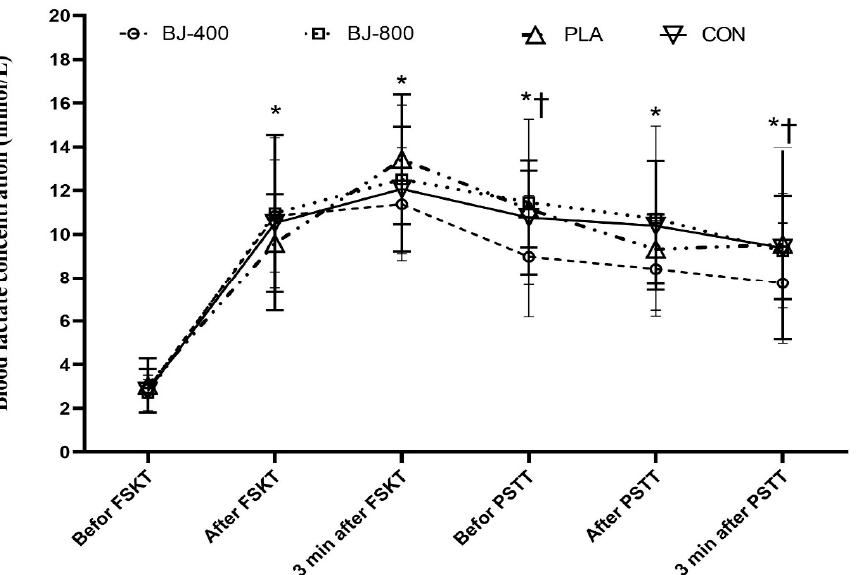
Figure 6. Blood lactate before and after Frequency Speed of Kick Test and Progressive Specific Taekwondo Test. Values are presented as mean and standard deviation. BJ, beetroot juice; PLA, placebo; CON, control. * Significant difference before FSKT in all treatments ( p < 0.05). † Significant difference 3 min after FSKT in all treatments ( p < 0.05).